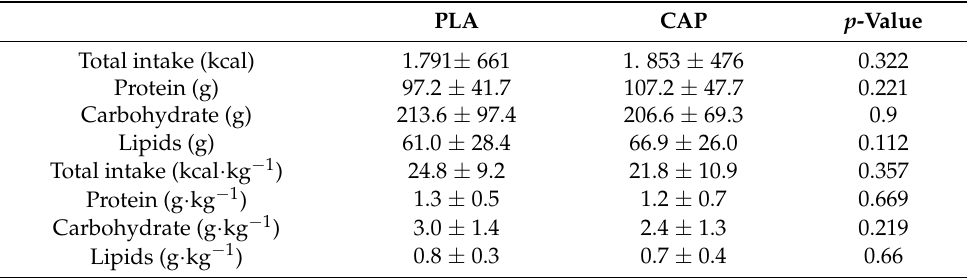
Table 2. Dietary intake and macronutrient distribution 24 h before each